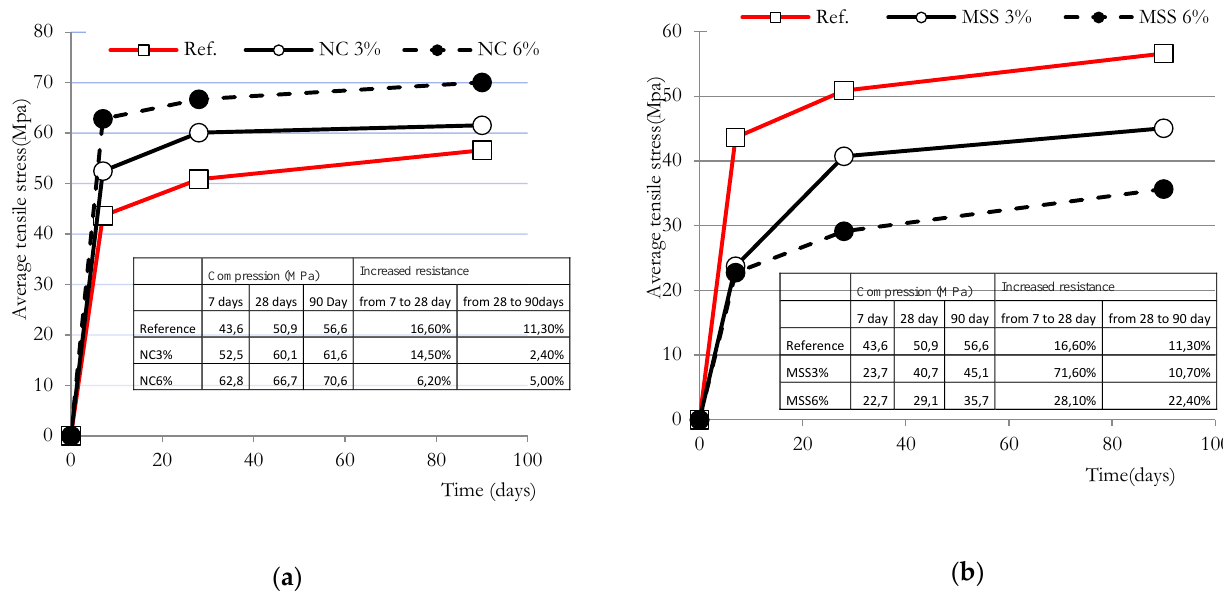
Figure 2. Compression resistance evolution (MPa). ( a ) Calcium nitrate and ( b ) silicate sodium. The comma between the numbers in the figure represents the decimal point.